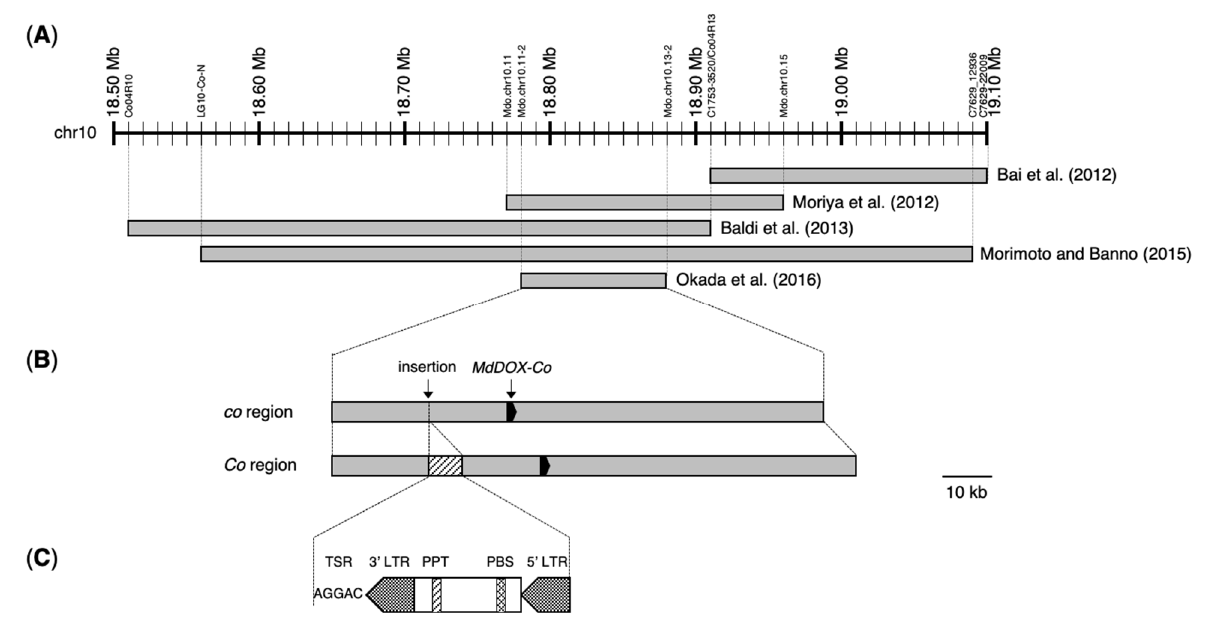
Figure 2. Identifying an insertional mutation by positional cloning. ( A ) Fine mapping of the Co locus (gray bars) on chromosome 10. ( B ) Difference of genomic structures between the co and Co regions. MdDOX-Co is located approximately 16 kb downstream of the insertion. ( C ) Structure of the 8.2 kb insertion sequence. LTR, long terminal repeat; PBS, primer binding site; PPT, polypurine tract; TSR, target site repeat. Reproduced with data from [21–25].